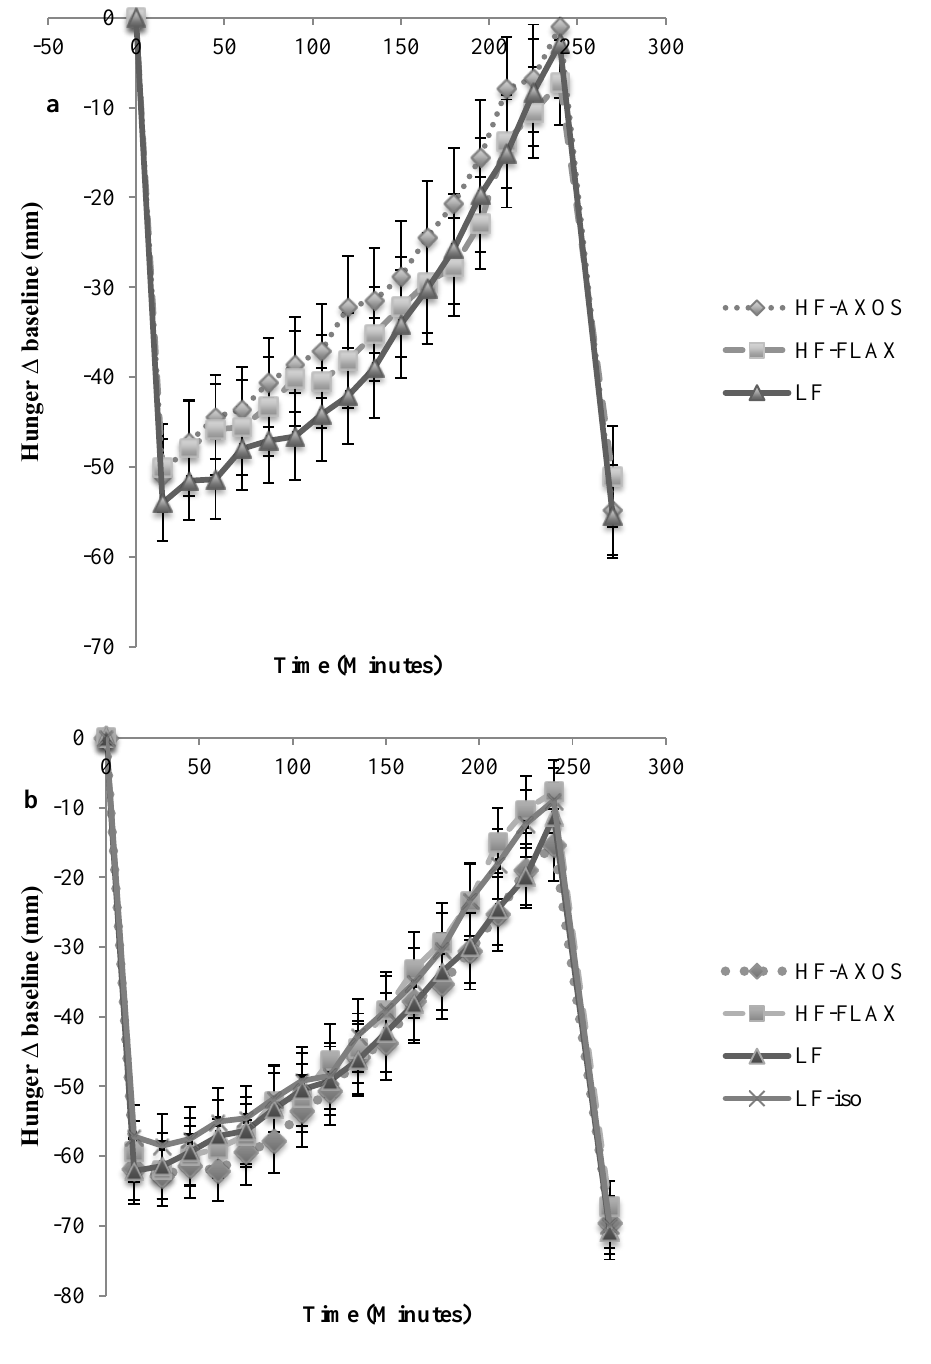
Figure 1. Hunger Score change from baseline following consumption of each breakfast. ( a ) Clinical Trial 1. Data are presented as mean ± SEM, based on 30 subjects. ( b ) Clinical Trial 2. Data are presented as mean ± SEM, based on 36 subjects. There were no significant differences between treatments at any time point ( p > 0.05) in either trial. LF: low-fiber RTEC; HF-AXOS: high-fiber (HF) RTEC with AXOS fiber; HF-FLAX: high-fiber (HF) RTEC with FLAX fiber; LF-iso: isocaloric RTEC to that of the HF